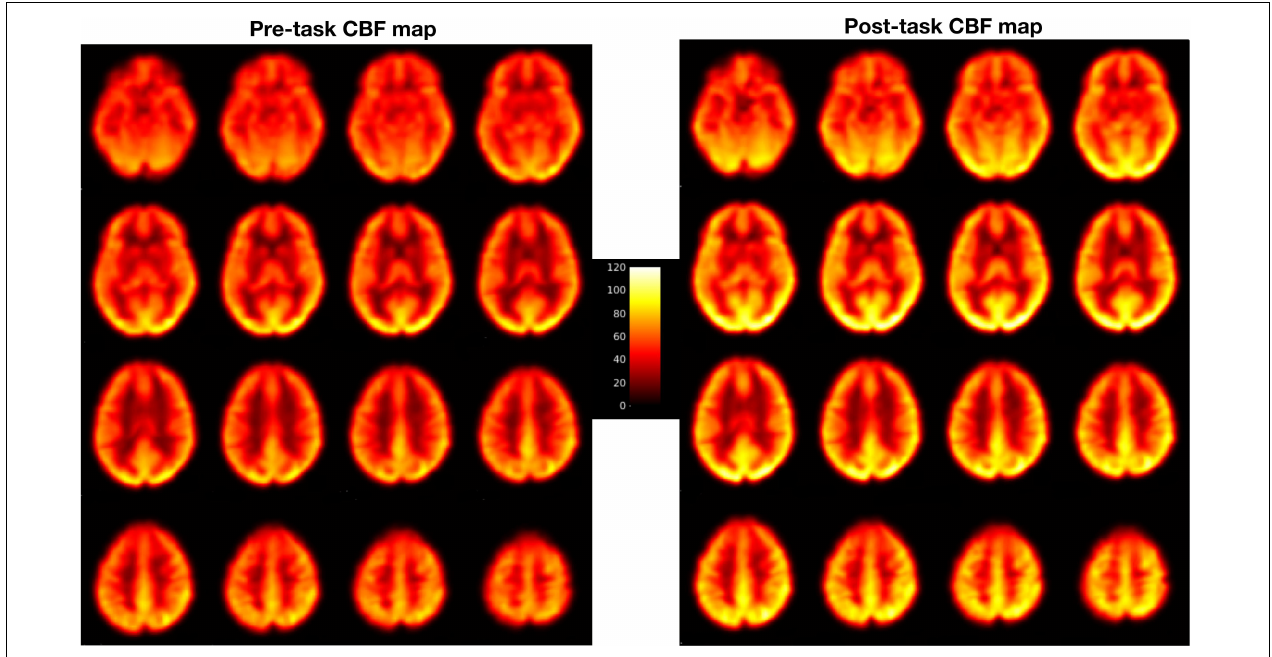
FIGURE 1 | Pre- and post-task CBF maps of one representative PD patient.